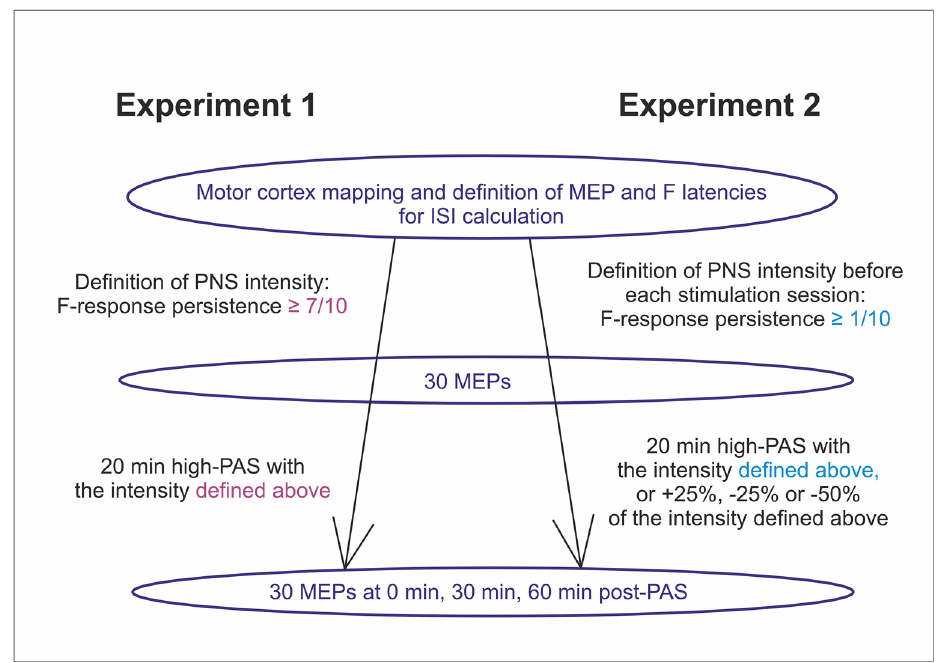
Figure 1. Experimental setup. AH abductor hallucis muscle, MEP motor evoked potential, ISI interstimulus interval, RMT resting motor